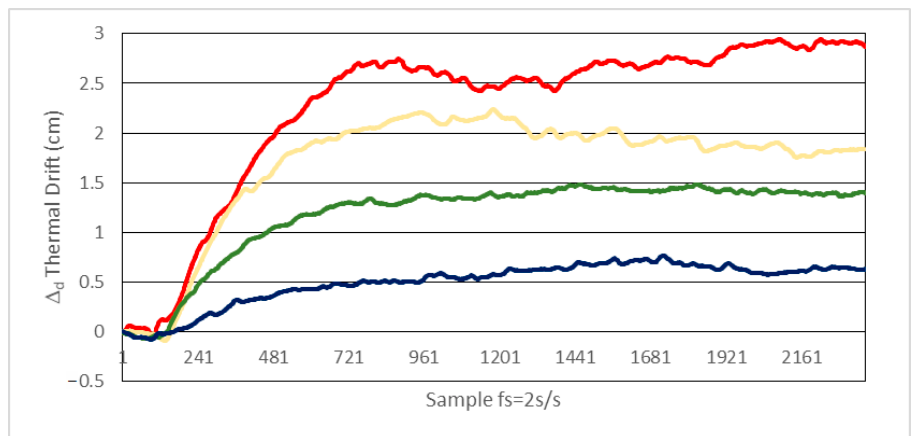
Figure 9. Distance error due to phase thermal drift with Cf = 1.2 pF and temperature increment from 25 ° C to 35 ° C (+10 ° C). Blue line: Rf = 3.9 K Ω , green line: Rf = 6.8 K Ω , orange line: Rf = 12 K Ω and red line: Rf = 22 K Ω .